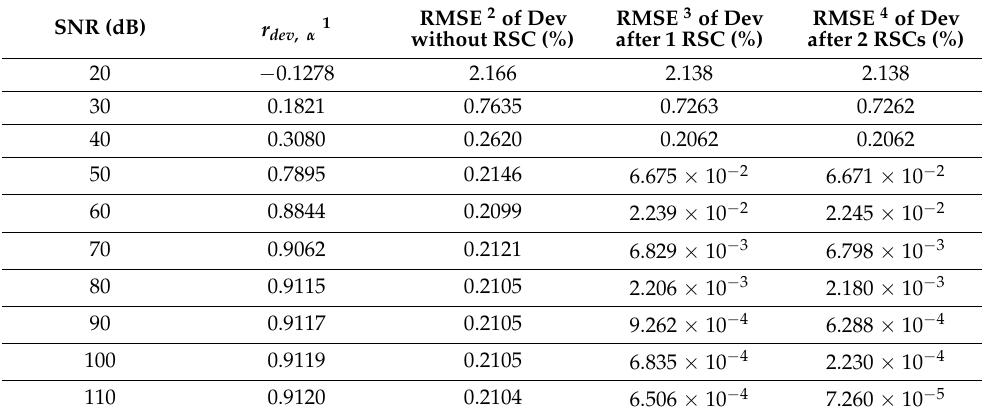
1234 Average of measured values after 10 simulations for each group with the same